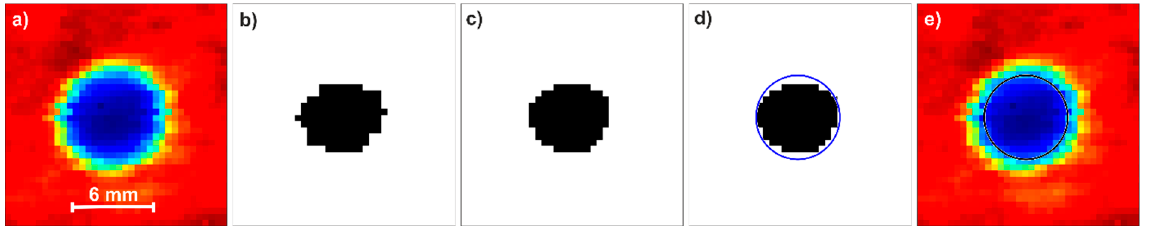
Figure 8. C-scan of the 6 mm hole during processing: raw ( a ), binarization ( b ), filtration ( c ), finding the circle with circular Hough transform ( d ), and the circle marked on the original image ( e ).